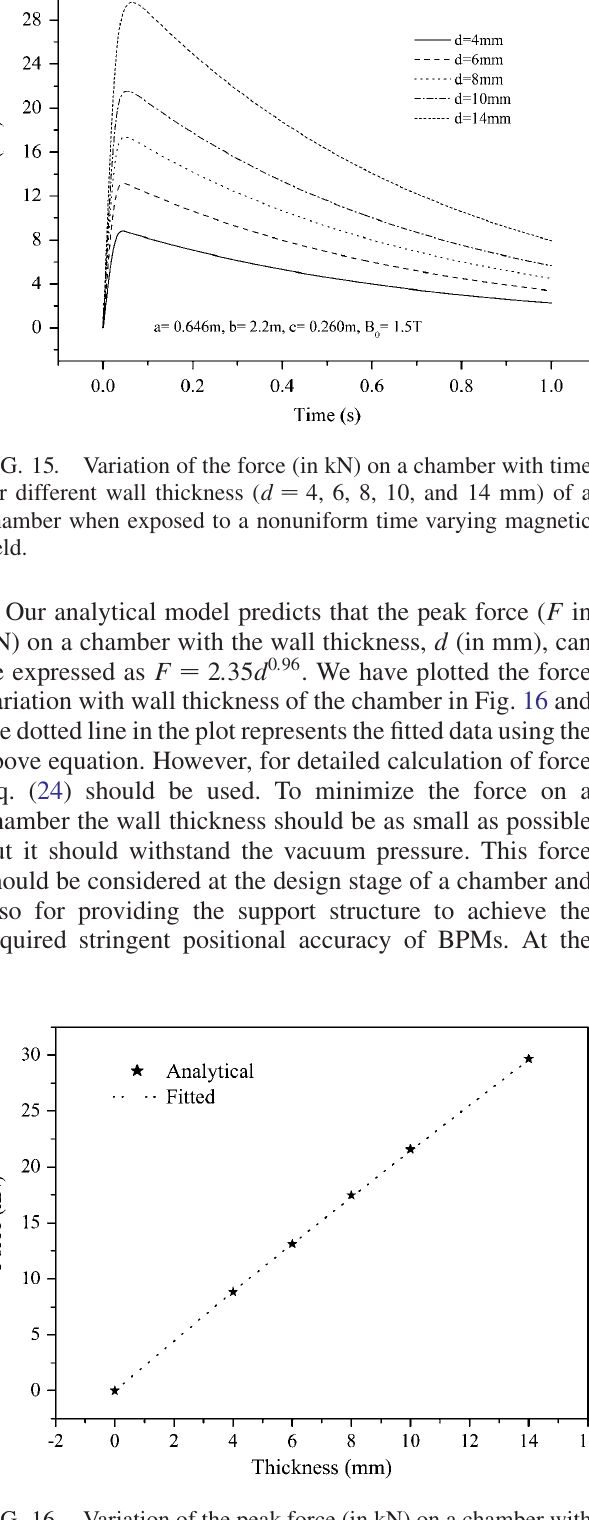
FIG. 16. Variation of the peak force (in kN) on a chamber with the wall thickness of a chamber keeping other parameters constant ( a ¼ 0 : 646 m , b ¼ 2 : 2 m , c ¼ 0 : 260 m , and B 0 ¼ 1 : 5 T ) when exposed to a nonuniform time varying magnetic field.